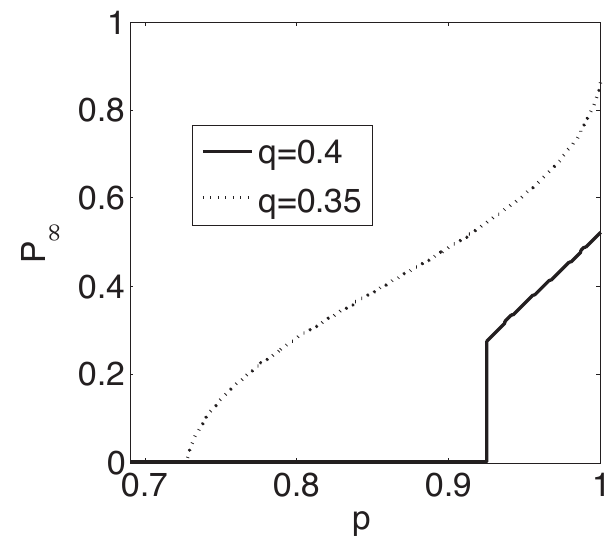
Figure 6. The giant component for an RR NON formed of RR networks with feedback condition P as a function of p for the RR of degree k = 6 and m = 3 , for two different ∞ values of q . The curves are obtained using Equation (8), which shows a first order phase transition when q is large, but a second order phase transition when q is small. After